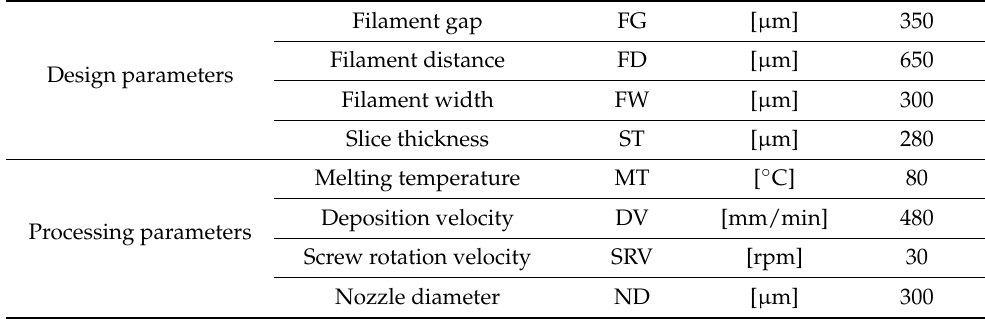
Table 1. D scaffold design and AM extrusion-based processing